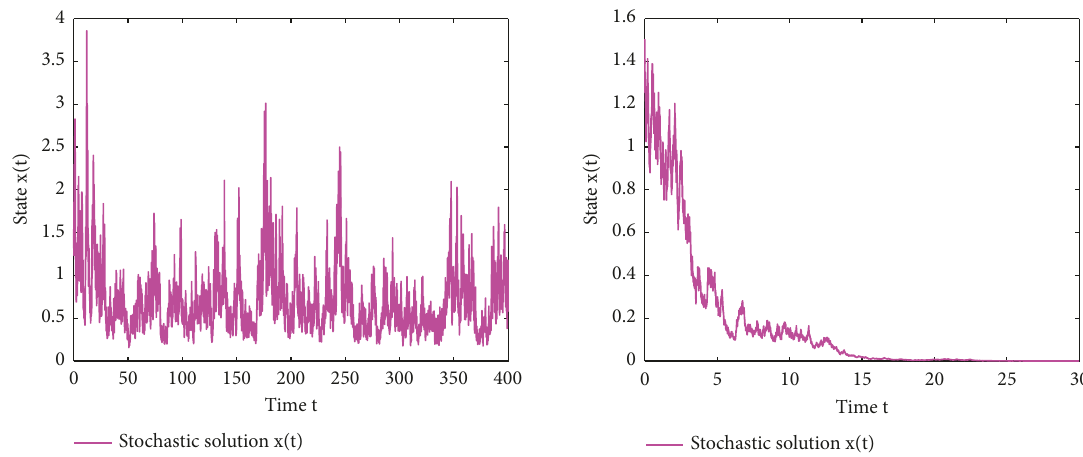
Figure 4: Stochastic trajectories of subsystems (109) and